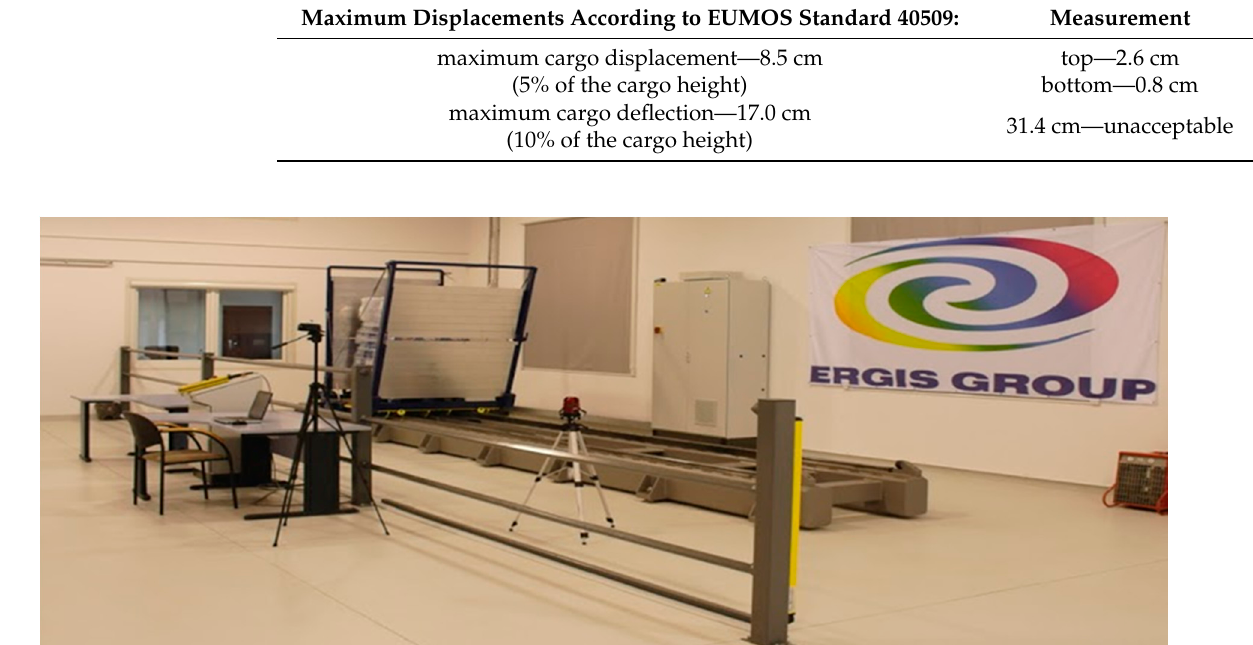
Figure 8. Cargo (PUL) on the acceleration ramp.